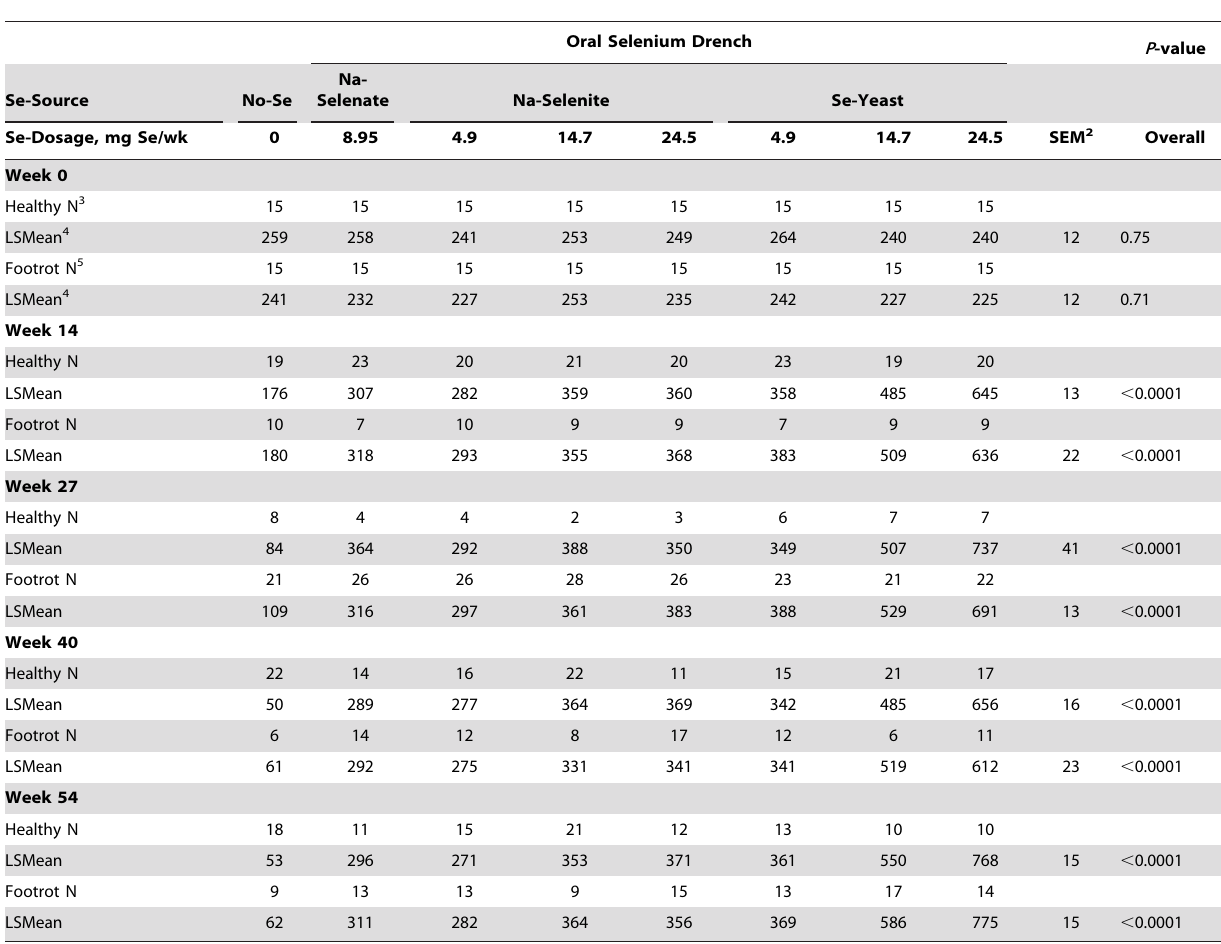
Table 1. Whole-blood Se concentrations (ng/mL) in ewes after weekly oral drenching with no Se, inorganic Se (Na-selenate or Na- selenite), and organic Se (Se-yeast) at varying supplementation rates (4.9, 14.7, and 24.5 mg Se/wk; Na-selenate only at 8.95 mg Se/ wk) for 62 wk.